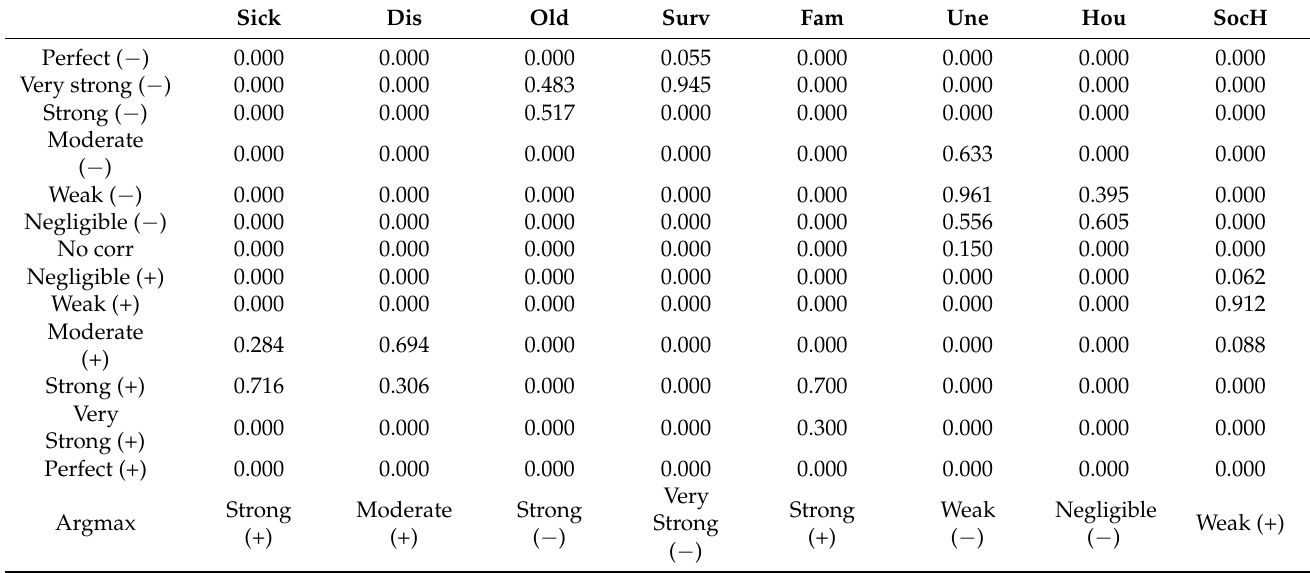
Table 14c. Value of the compatibility indexes (7b) of the correlations between DF and the proportion that each kind of social expense suppose in overall SE and the labels of the linguistic variable “correlation coefficient” (EU-15